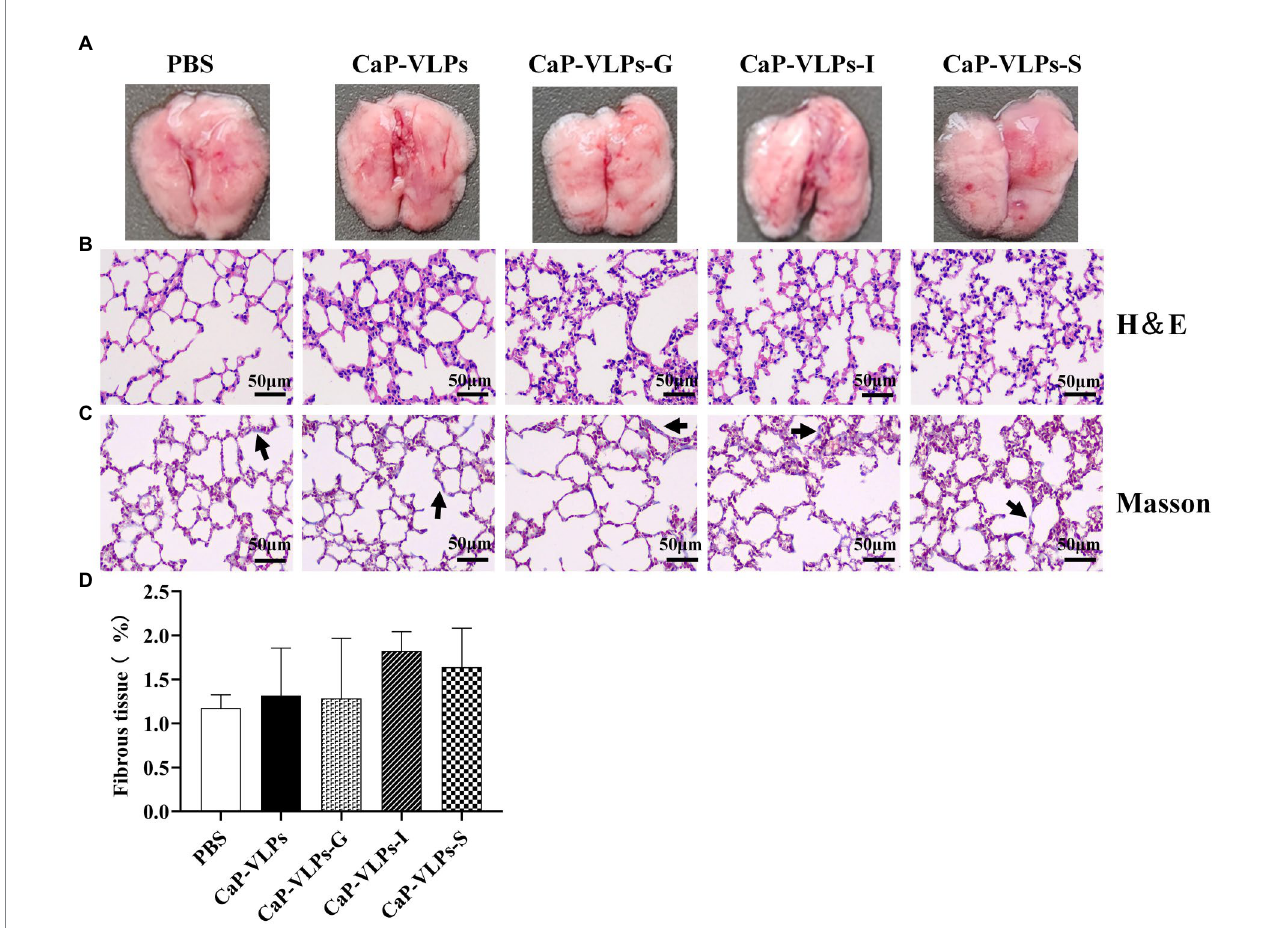
FIGURE 6 Gross observation and histopathological analysis of lungs. (A) The lung macroscopic structure on day 28 after the first immunization. (B) Representative photographs of H&E-stained lung sections in each group (black bar = 50 μ m). (C) Representative micrographs of Masson trichrome staining, with blue- stained collagen fibers (black arrow; black bar = 50 μ m). (D) Percentage of fibrous tissue expression area in lung tissue.